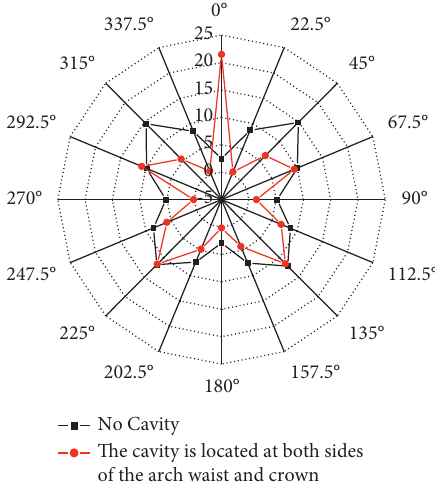
Figure 30: Safety coefficient of the segment cross section of the cavity behind the bilateral arch waist and vault.